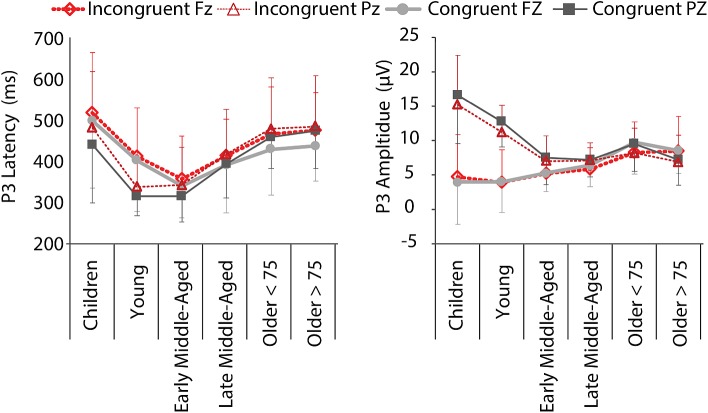
P3 mean latencies and amplitudes at electrodes Fz (thick lines, light colors) and Pz (thin lines, dark colors) for C (gray, solid) and IC (red, dashed) conditions, per age group. Negative error bars represent standard deviations for C, while positive error bars represent standard deviations for IC condition.